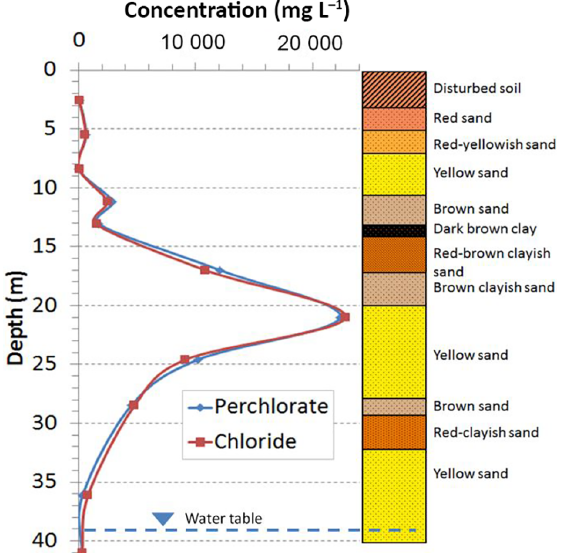
Figure 2. Schematic illustration of the vadose zone monitoring sys- tem installed in the vadose zone under the infiltration pilot site. In the picture above the vadose zone, the irrigation system at the site is being